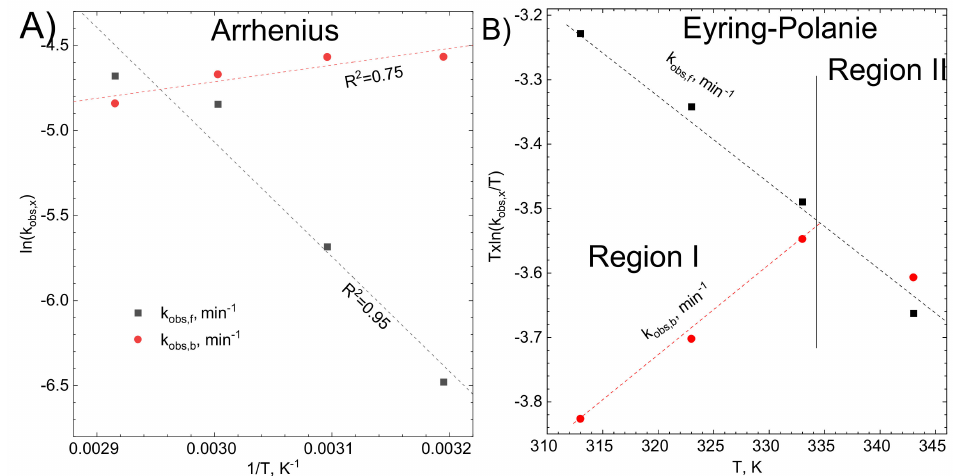
Figure 12. Graphical determination of ( A ) activation energy using Arrhenius model ( B ) enthalpy and entropy of activation using Eyring-Polanyi model. Experimental conditions: stirring rate 1200 rpm,